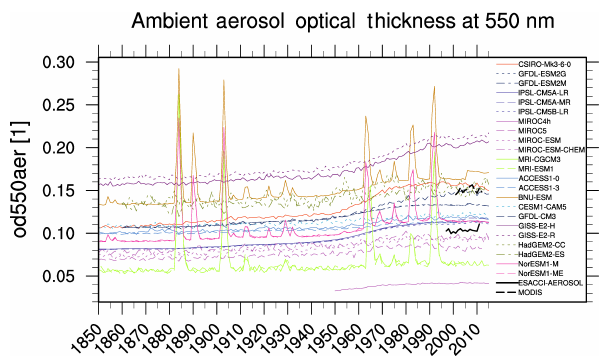
Figure 23. Time series of global oceanic mean aerosol optical depth (AOD) from individual CMIP5 models’ historical (1850–2005) and RCP 4.5 (2006–2010) simulations, compared with MODIS and ESACCI-AEROSOL satellite data. All models simulate a positive trend in AOD starting around 1950. Some models also show dis- tinct AOD peaks in response to major volcanic eruptions, e.g. El Chichon (1982) and Pinatubo (1991). The models simulate quite a wide range of AODs, between 0.05 and 0.20 in 2010, which largely deviates from the observed values from MODIS and ESACCI- AEROSOL. A significant difference, however, exists also between the two satellite data sets (about 0.05), indicating an observational uncertainty. Similar to Fig. 9.29 of Flato et al. (2013) and produced with namelist_aerosol_CMIP5.xml